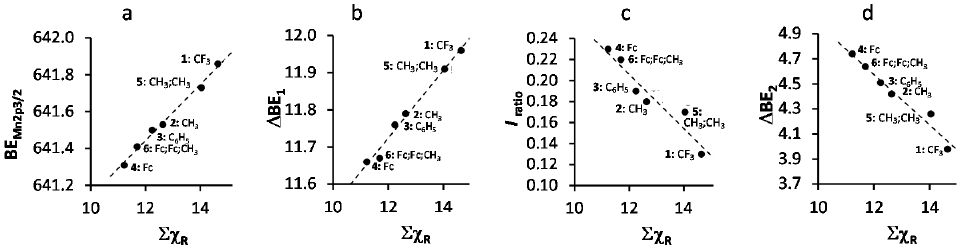
Figure 3. ( a ) Relationship between the binding energy of the main Mn 2p 3/2 photoelectron envelope and the sum of β -diketonato ligand Gordy scale R-group electronegativities, Σχ R , of 1 – 6 ; ( b ) Relationship between the spin orbit splitting of the main Mn 2p 3/2 and Mn 2p 1/2 photoelectron envelopes ( Δ BE 1 = BE Mn2p1/2 − BE Mn2p3/2 ) and Σχ R ; ( c ) Relationship between the ratio of the intensities of the satellite and main Mn 2p 3/2 photoelectron line, I ratio = ( I Mn2p3/2satel )/( I Mn2p3/2main ), and Σχ R of 1 – 6 ; ( d ) Relationship between the difference between the maximum binding energy of the main Mn 2p 3/2 photoelectron line and the satellite Mn 2p 3/2 photoelectron line ( Δ BE 2 = BE Mn2p3/2satel − BE Mn2p3/2main ) and Σχ R of 1 – 6 .